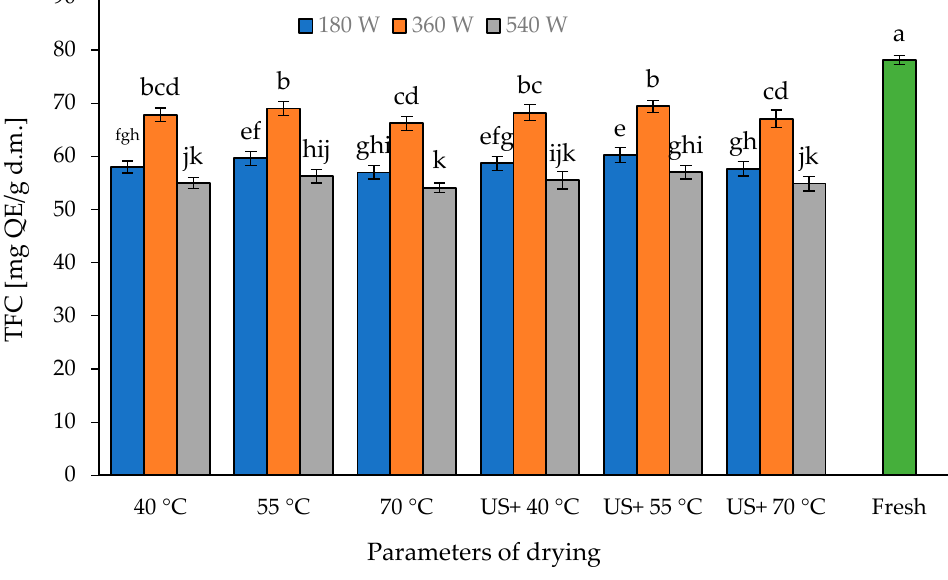
Figure 7. Effects of US pretreatment, MW power and air temperature during drying on total flavonoid content (TFC) in hawthorn. Data followed by different letters (a–k) in each column are significantly different at p < 0.01. Columns with the same letters are not significantly different.